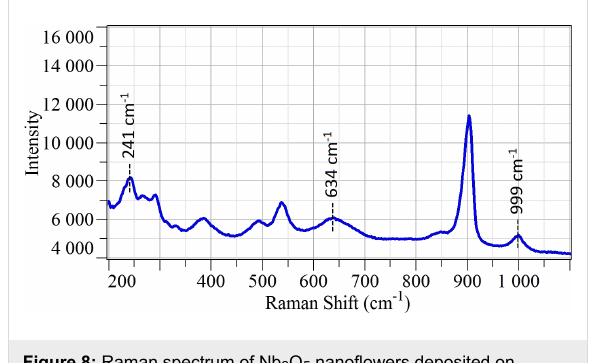
Figure 8: Raman spectrum of Nb 2 O 5 nanoflowers deposited on alumina substrate measured in ambient air at room temperature. The niobium(V) oxide peaks in Figure 8 (marked by dashed lines) match the ones reported in literature [9,10]. The peak